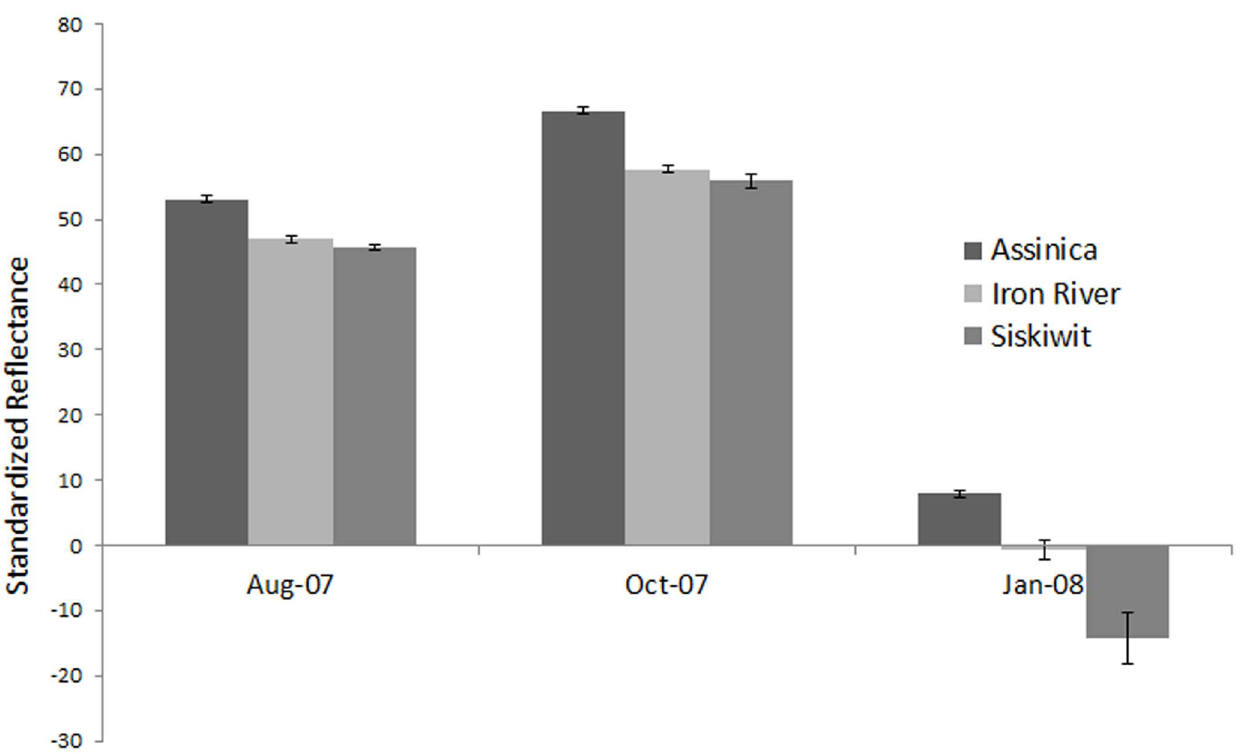
Figure 2. Standardized reflectance for each strain across sampling time points. *Indicates that all three strains are significantly different. **Indicates that Assinica is significantly different from both Siskiwit and Iron River. Magnitude of reflectance for the last time point is not directly comparable to the first two as a different intensity standard was